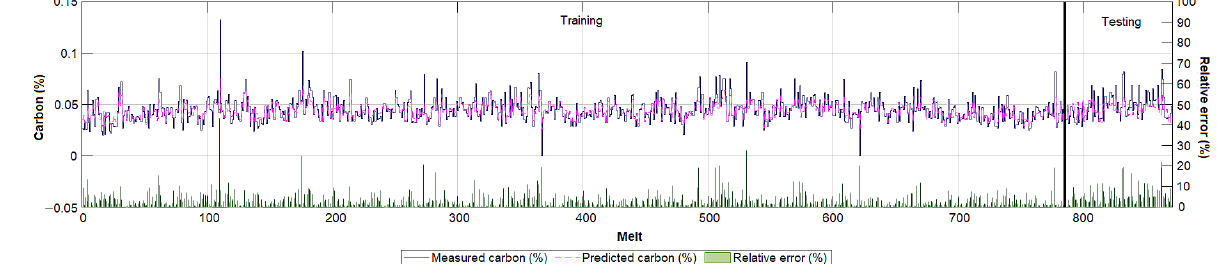
Figure 13. Prediction of endpoint carbon concentration in melt by SVR model with a Gaussian kernel.